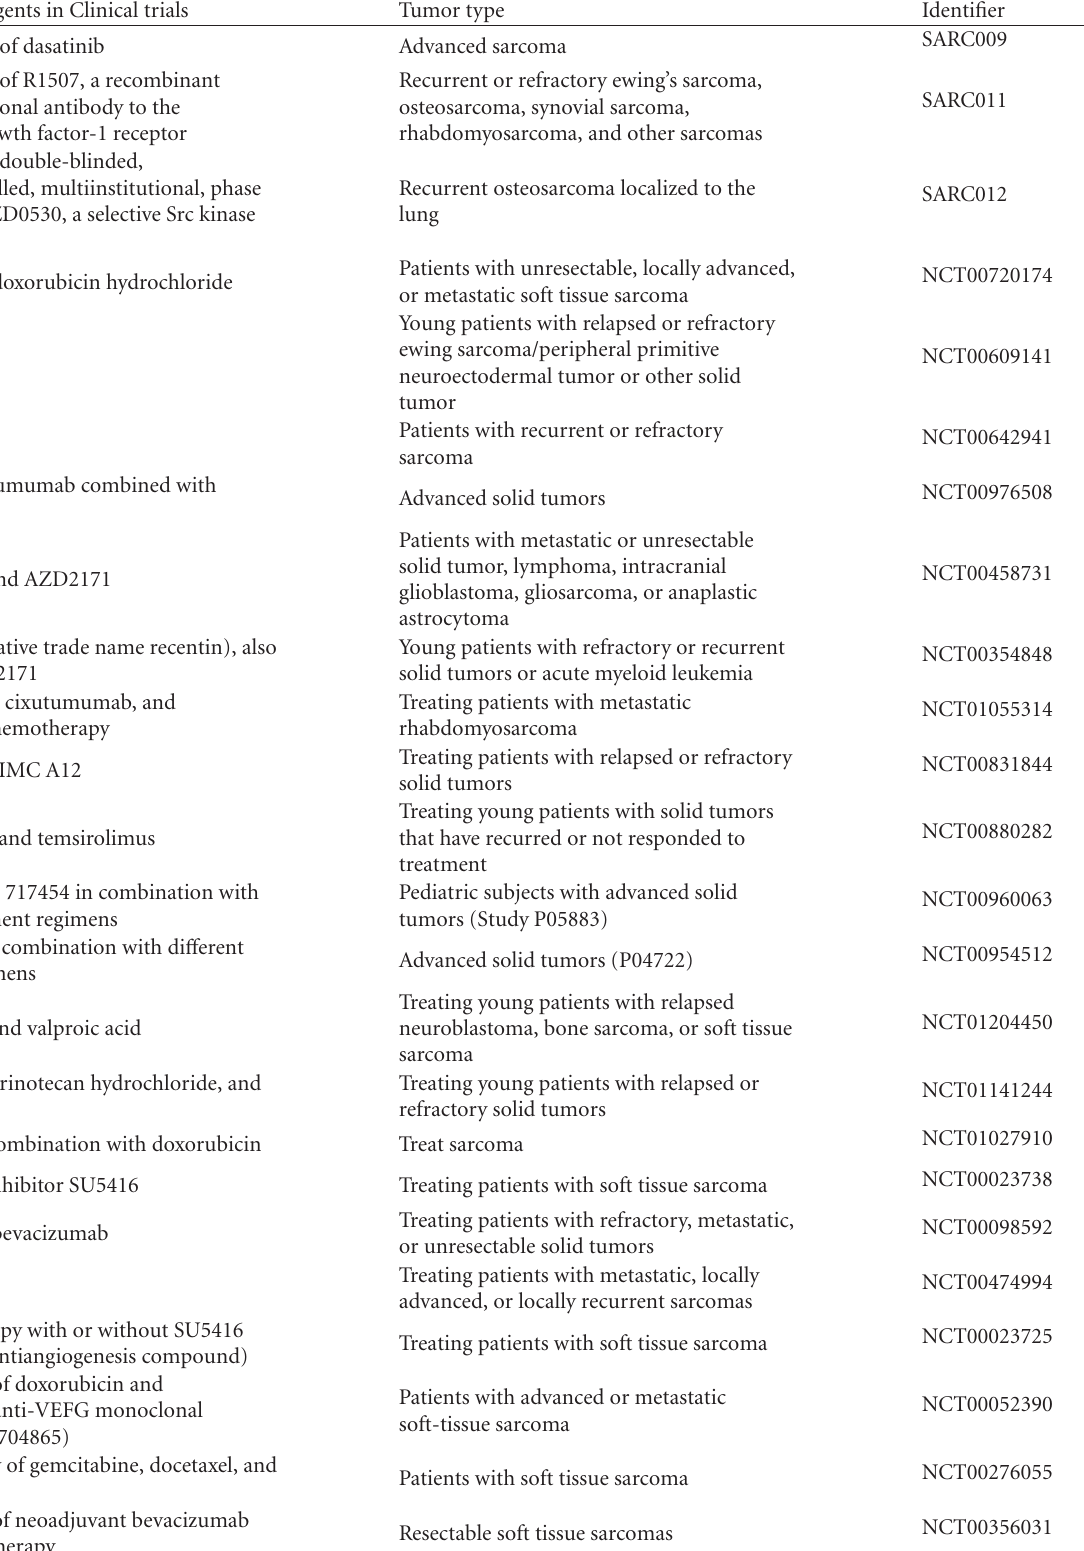
Table 1: Summary of select recent clinical studies for